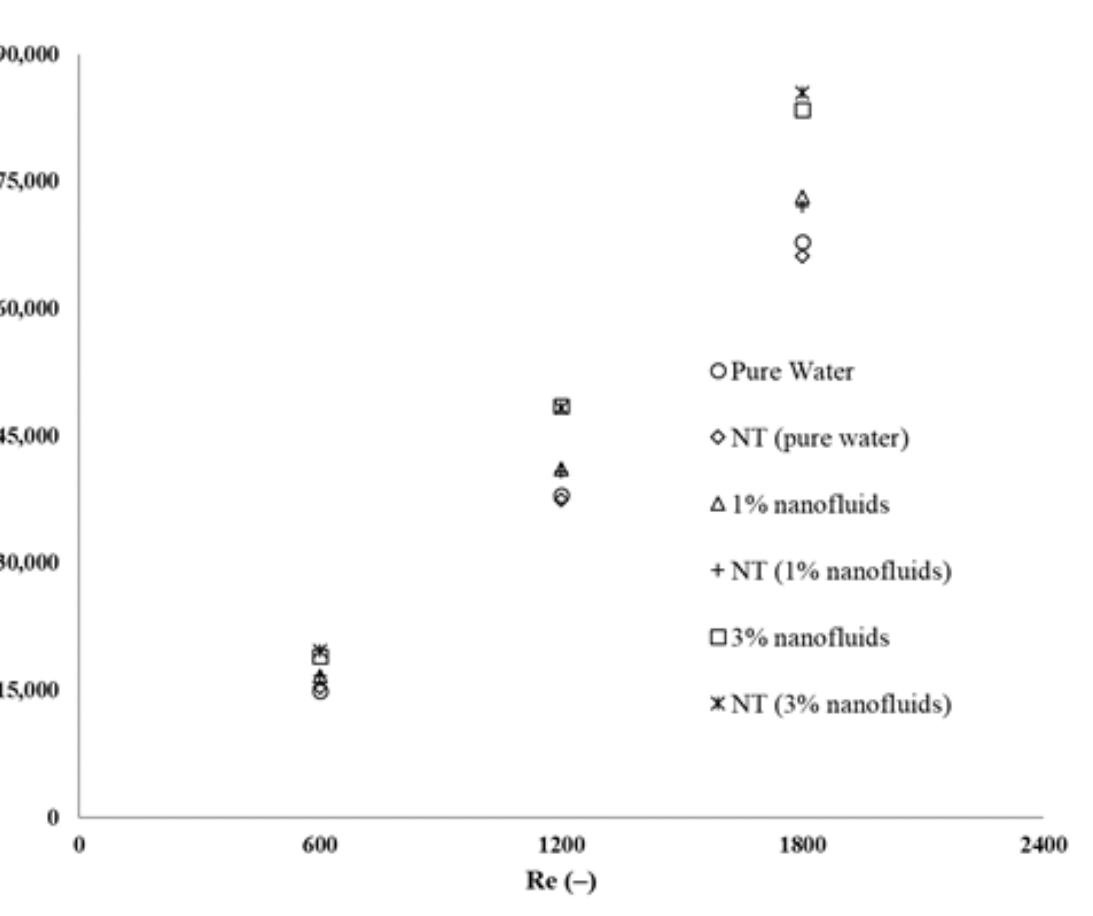
Figure 4. Comparison of the pressure drop values for different Reynolds numbers with water and water/Al 2 O 3 fluids obtained by the numerical tests (NT) with the results given in Shi et al. [17].